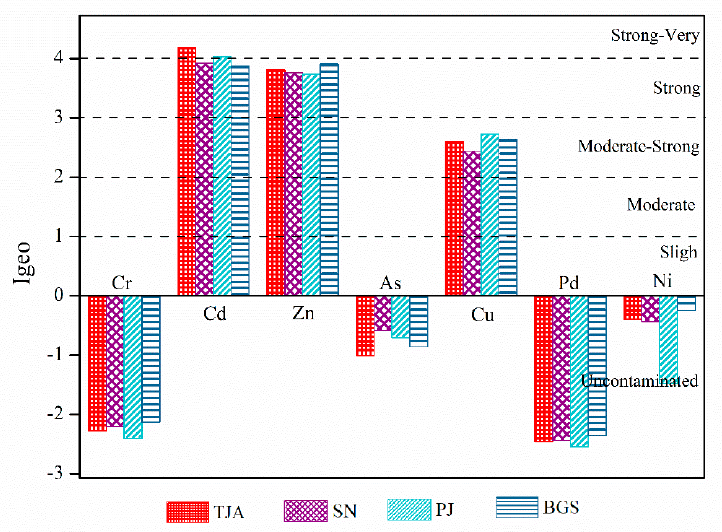
Figure 3. The Igeo results for the heavy metals in the sludge. TJA (Tianjiaan), SN (Shannan), PJ (Panji), and BGS (Bagongshan).